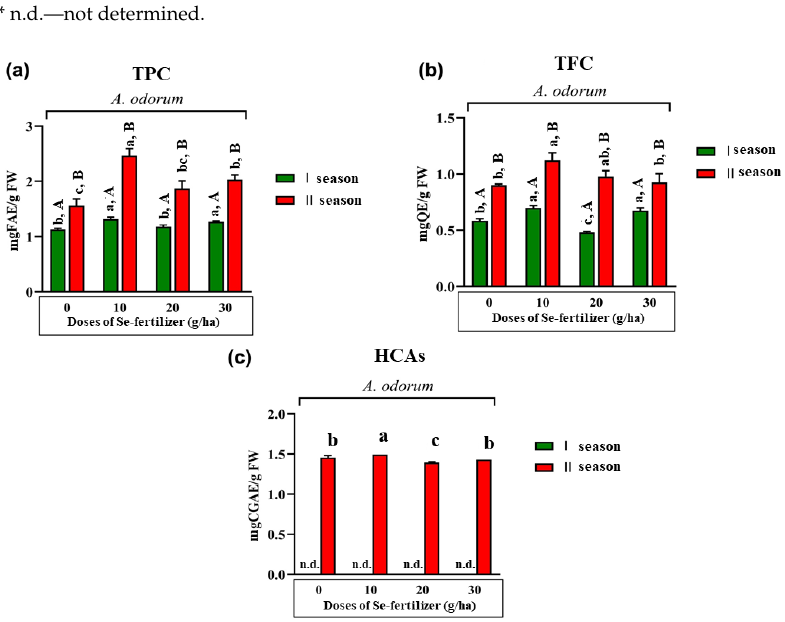
Figure 1. Effect of different doses (control—0, 10, 20 and 30 g per ha) of Se fertilizer and growing season on the total content of free phenolics (TPC): ( a ) total content of free flavonoids (TFC); ( b ) and total content of free hydroxycinnamic acid derivatives (HCAs) ( c ) in the edible parts (leaves) of A. odorum . The bars with (+) standard deviation represent mean values; lowercase letters indicate comparisons between treatments (applied doses of Se-fertilizer (g/ha)); uppercase letters indicate comparisons between seasons; different letters indicate statistically significant differences according to Tukey’s HSD test ( p < 0.05). n.d.—not detected; FAE—ferulic acid equivalents; QE—quercetin equivalents; CGAE—chlorogenic acid